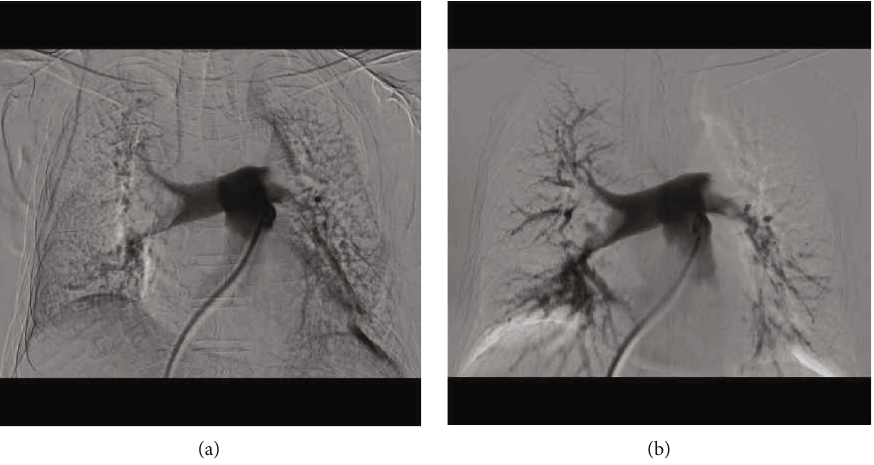
Figure 5: Angiographic imaging before (a) and after (b) Angiojet system therapy in the second patient. Table 1: Clinical characteristics in these two patients.